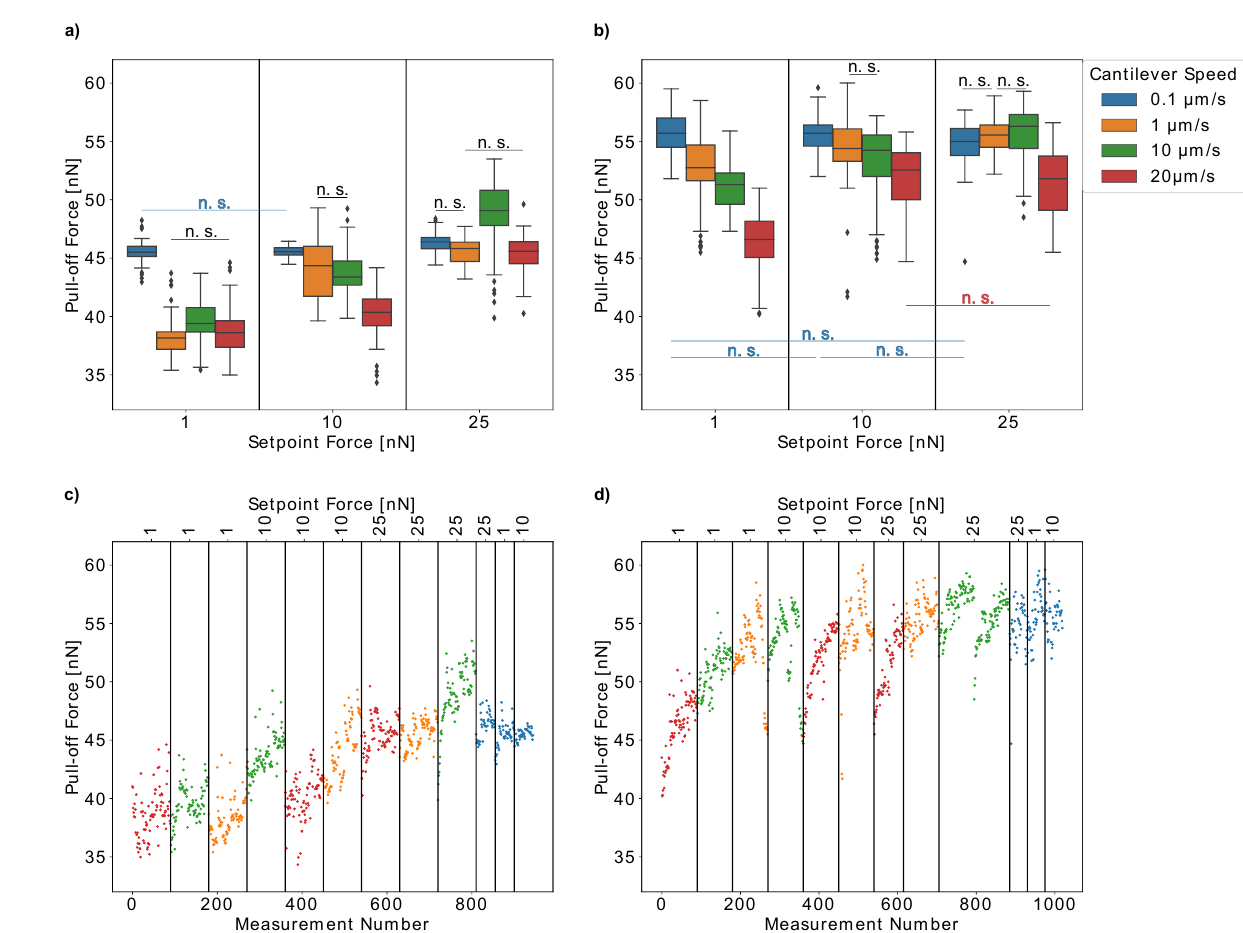
Figure 6. The influence of setpoint force and cantilever speed on pull-off forces for two individual pollen grains of Hypochaeris radicata that were older than seven days. ( a , b ) Box plots of the pull-off forces. ( c , d ) Pull-off forces versus measurement number. We marked only boxes that were not significantly different. In contrast to fresh pollen, the old pollen show a decrease in pull-off forces with increasing cantilever speed. For speeds above 1 µm/s, the pull-off forces increased with an increasing setpoint force. The pull-off forces for old pollen have a tendency to increase with the measurement number ( c , d ), which was not the case for fresh pollen. n.s.: no